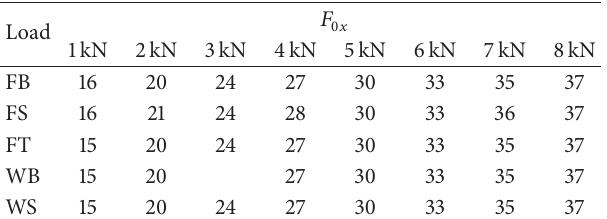
Table 7: The vibration frequency of the C1 point for